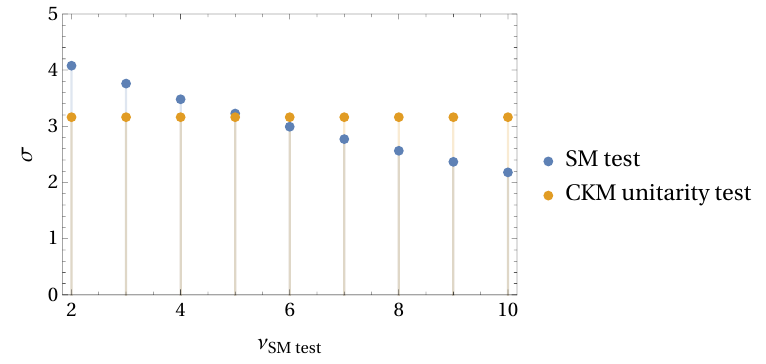
Figure 1 . Toy example for the comparison of signi(cid:12)cances of the rejection of the SM and CKM unitarity for (cid:12)xed (cid:1) (cid:31) 2 = 20 and (cid:1) (cid:31) 2 = 10 as a function of (cid:23) SM test (cid:21) 2. Note that unitarity test SM test (cid:23) unitarity test = 1 always and (cid:23) SM test = n (cid:0) 1 for n observables, see eq. (2.7). Of course in reality (cid:1) (cid:31) 2 and (cid:1) (cid:31) 2 would in general also change when (cid:23) SM test does. However, we can unitarity test SM test